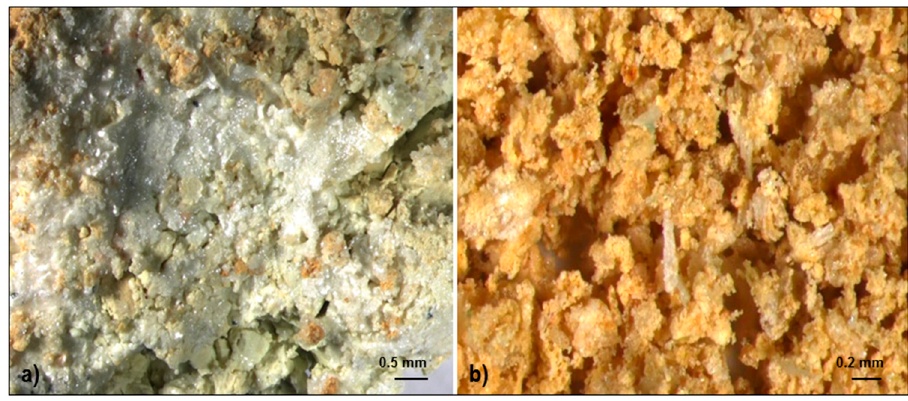
Figure 4. Stereomicroscope images of: ( a ) Alunite; ( b ) jarosite collected in the Algares adit.